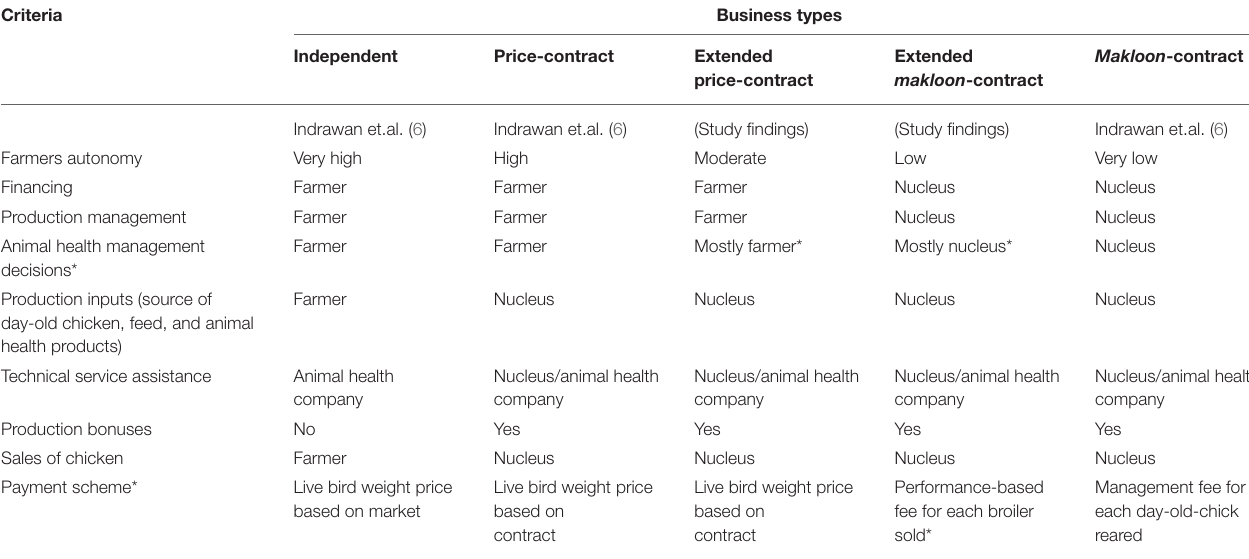
TABLE 1 | Classification of different business types in broiler farming based on the roles of broiler farmers and nucleus companies on different production and animal health aspects.